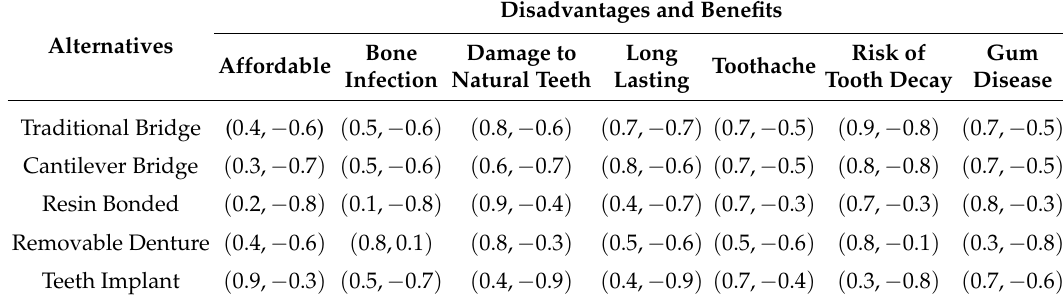
Table 9. Bipolar fuzzy decision matrix.